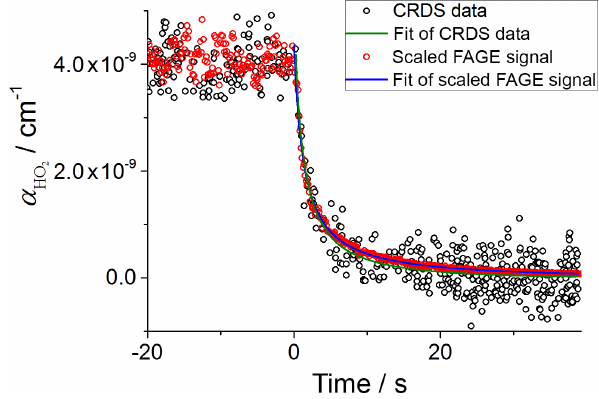
Figure 6. An example of a temporal decay of the HO 2 absorption coefficient at 1506.43nm from CRDS data (black circles) along with the FAGE signal scaled to overlap the CRDS data (see text for details). The traces were recorded at 295K and with a 1000mbar mixture of N 2 : O 2 = 4 : 1: [Cl 2 ] 0 ∼ 1.7 × 10 14 moleculecm − 3 and [CH 3 OH] 0 ∼ 2.0 × 10 14 moleculecm − 3 . The fit of Eq. (10) to the CRDS data (green line) gave = (3.59 ± 0.52) × 10 − 20 cm 2 molecule − 1 , while the fit σ HO 2 of Eq. (10) to the scaled FAGE data (blue line) resulted in = (3.54 ± 0.05) × 10 − 20 cm 2 molecule − 1 . The error limits σ HO 2 are statistical errors at the 1 σ